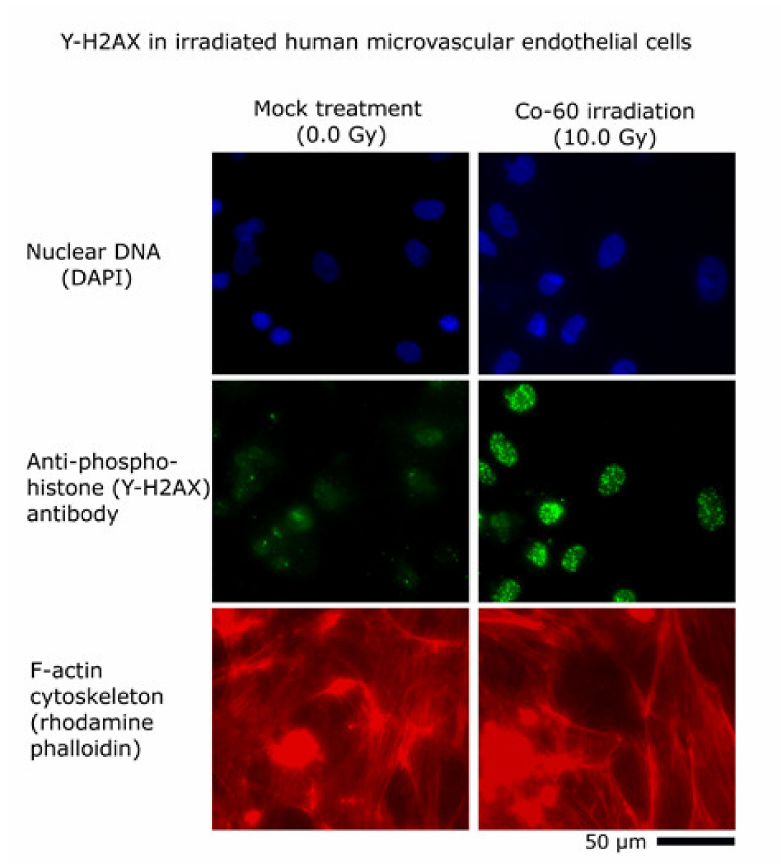
Figure 4. Irradiation of human microvascular endothelial cells with γ rays induces DNA damage. Images show DAPI-labeled cellular nuclei (top pair), γ -H2AX immunolabeling (middle pair), and rhodamine-phalloidin-labeled f-actin cytoskeleton (bottom pair). Double-stranded DNA breaks are evident in cells through immunocytochemistry for anti-phospho-histone H2A.X (serine 139), commonly termed γ -H2AX. Cells not exposed to γ rays (left image column) show very little γ -H2AX expression compared to cells exposed to 10 Gy of γ rays (right image column) from Co-60 source. The 50 µ m scale bar applies to all six